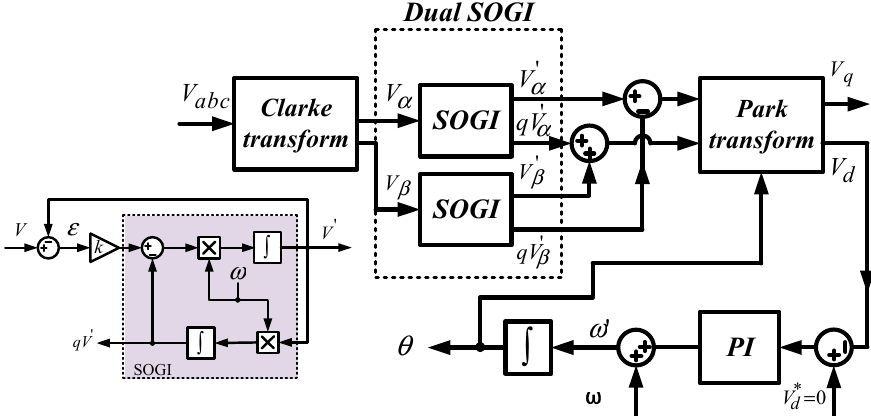
Figure 2. Block diagram of dual second-order generalized integrator phase-locked loop technique (DSOGI-PLL).